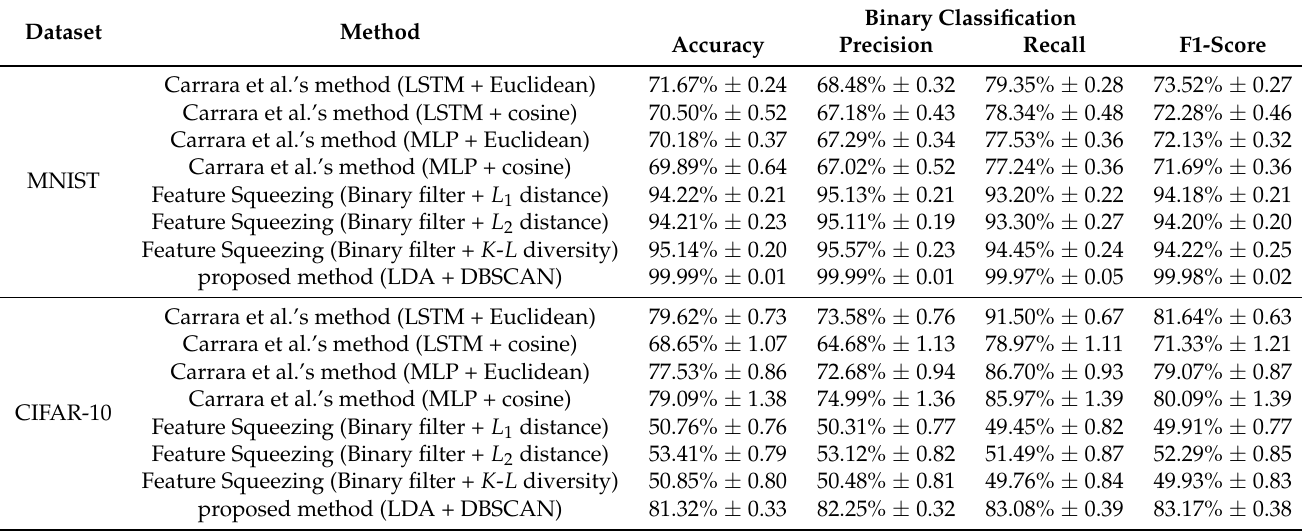
Table 4. Comparison results for binary classification with Carrara et al.’s method and Feature Squeezing.